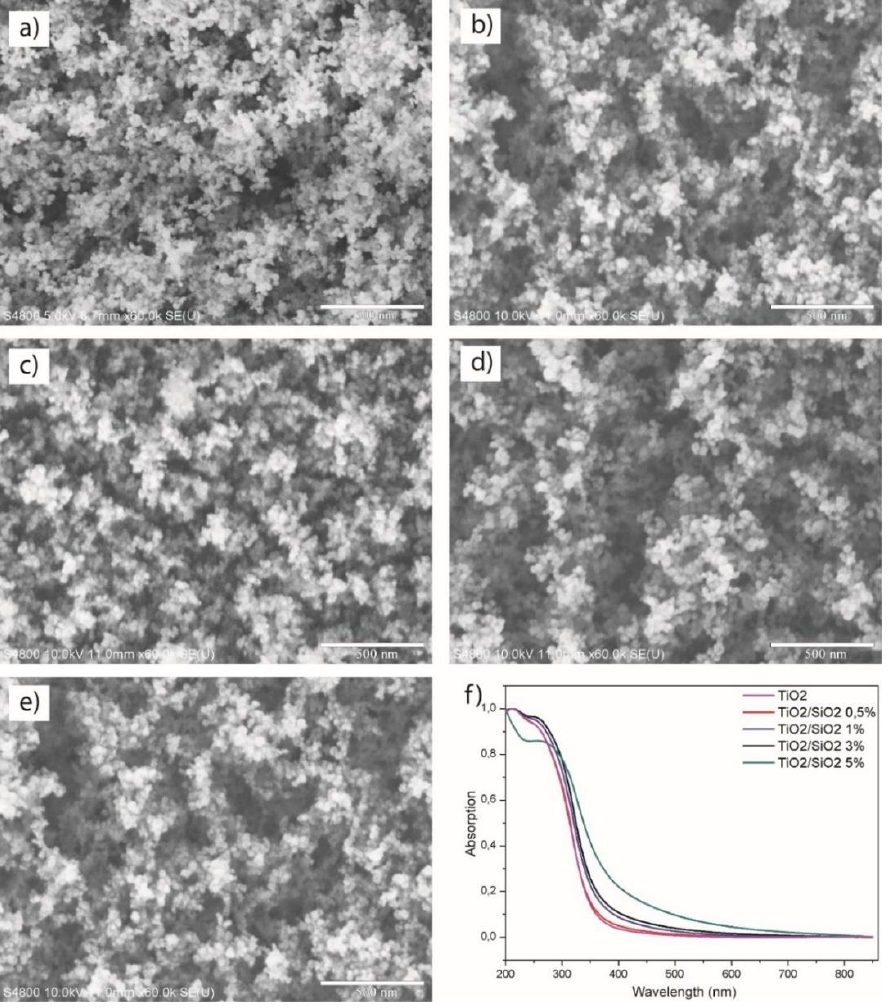
Figure 1. SEM images of ( a ) TiO 2 , ( b ) TiO 2 /SiO 2 99.5/0.5, ( c ) TiO 2 /SiO 2 99.0/1.0, ( d ) TiO 2 /SiO 2 97.0/3.0, ( e ) TiO 2 /SiO 2 95.0/5.0 and ( f ) UV-Vis absorption spectra of the corresponding samples.